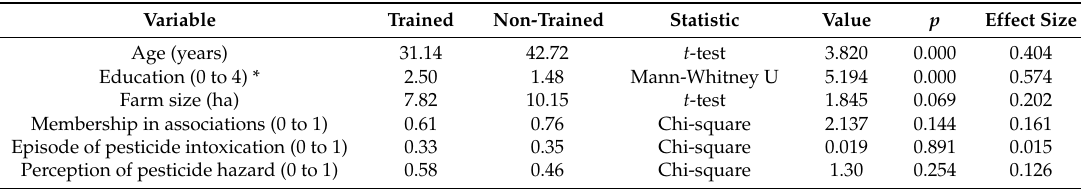
Table 1. Basic characteristics of the farmers